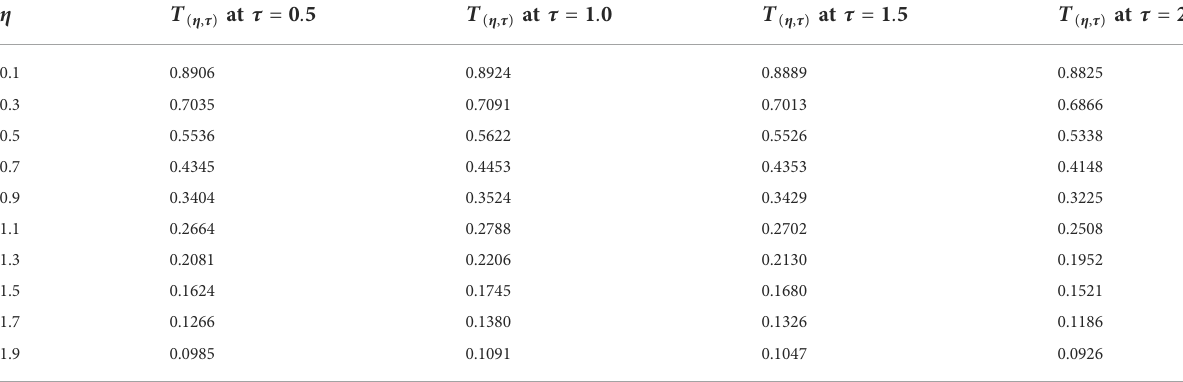
TABLE 2 Numerical analysis velocity pro fi le at different times. η v